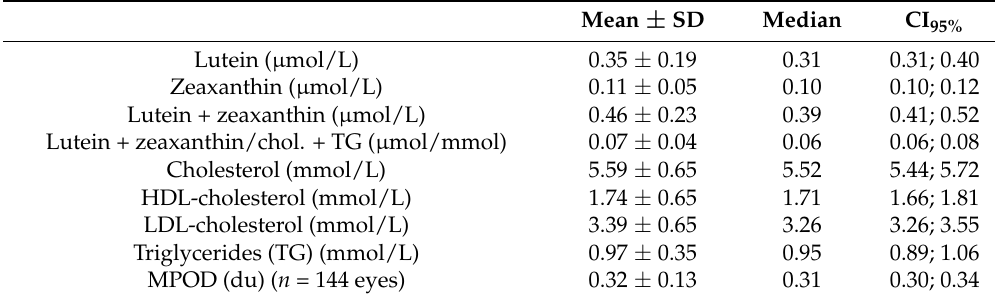
Table 1. Concentrations of the variables analyzed at baseline ( n =